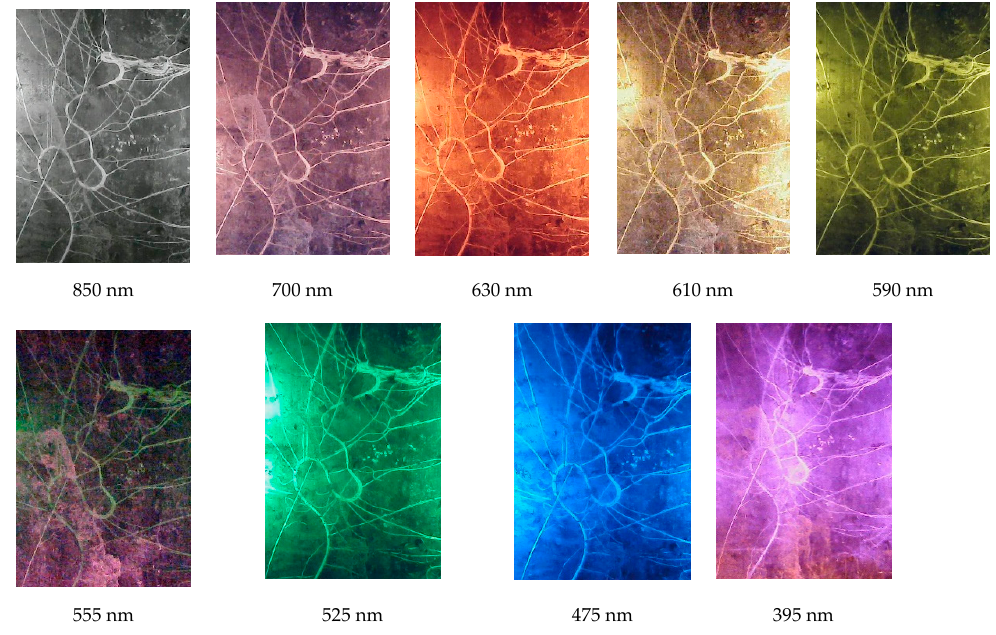
Figure 11. Multispectral root images at various wavelengths.